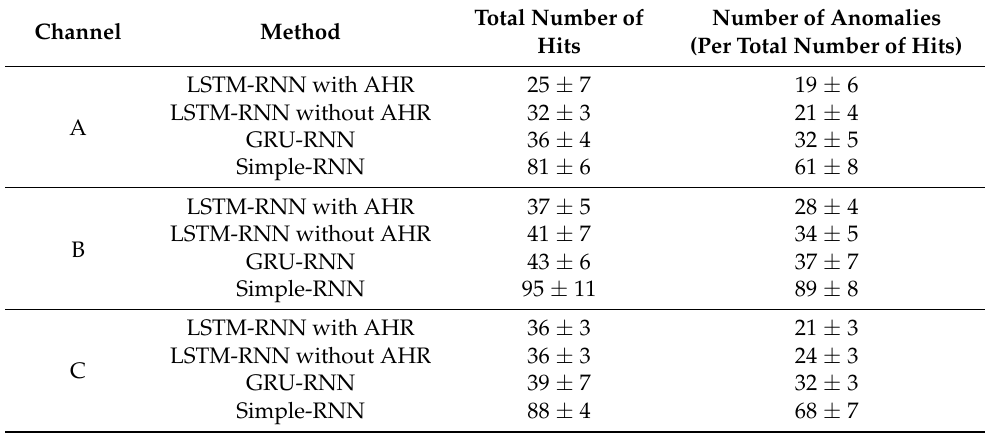
Table 3. The proposed method’s result in comparison with LSTM-RNN without AHR, GRU-RNN, and